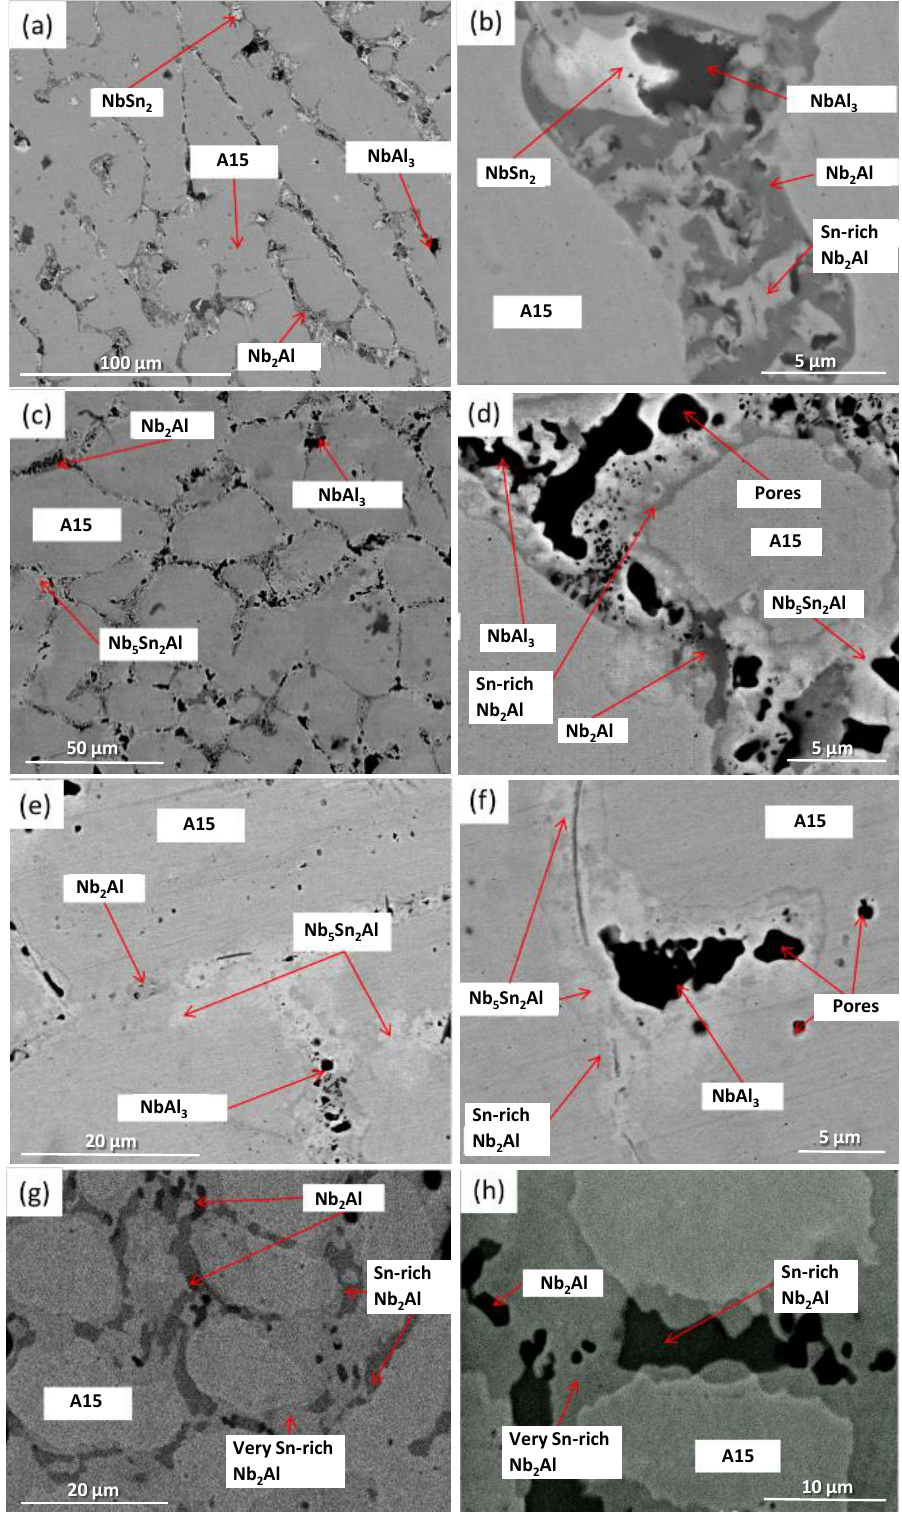
Figure2. Backscatteredelectron(BSE)imagesof( a , b )IP4-AC,( c , d )IP4-HT-900 ◦ C / 100h, ( e , f )IP4-HT-900 Figure 2. Backscattered electron (BSE) images of ( a , b ) IP4-AC, ( c , d ) IP4-HT-900 °C/100 h, ( e , f ) IP4-HT- ◦ C / 200 h and ( g , h ) IP4-HT-1200 ◦ C / 100 900 °C/200 h and ( g , h ) IP4-HT-1200 °C/100 h.